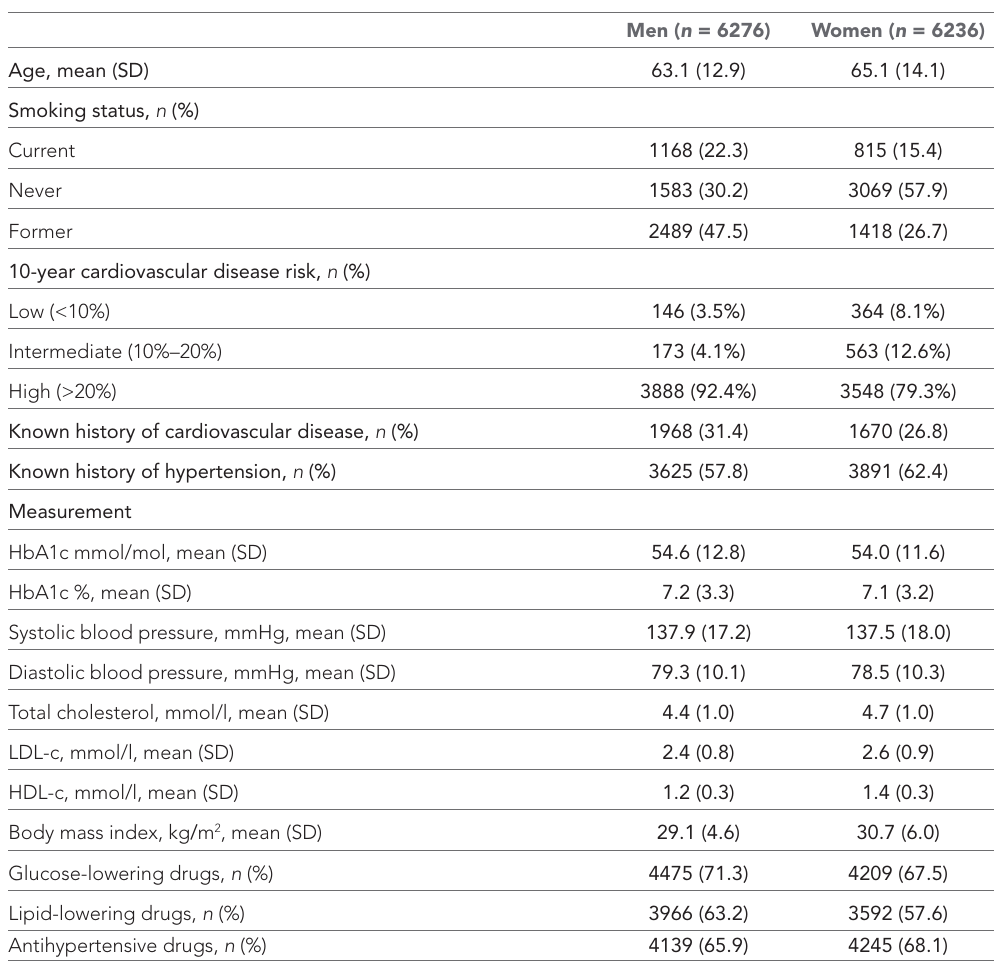
Table 1 Baseline